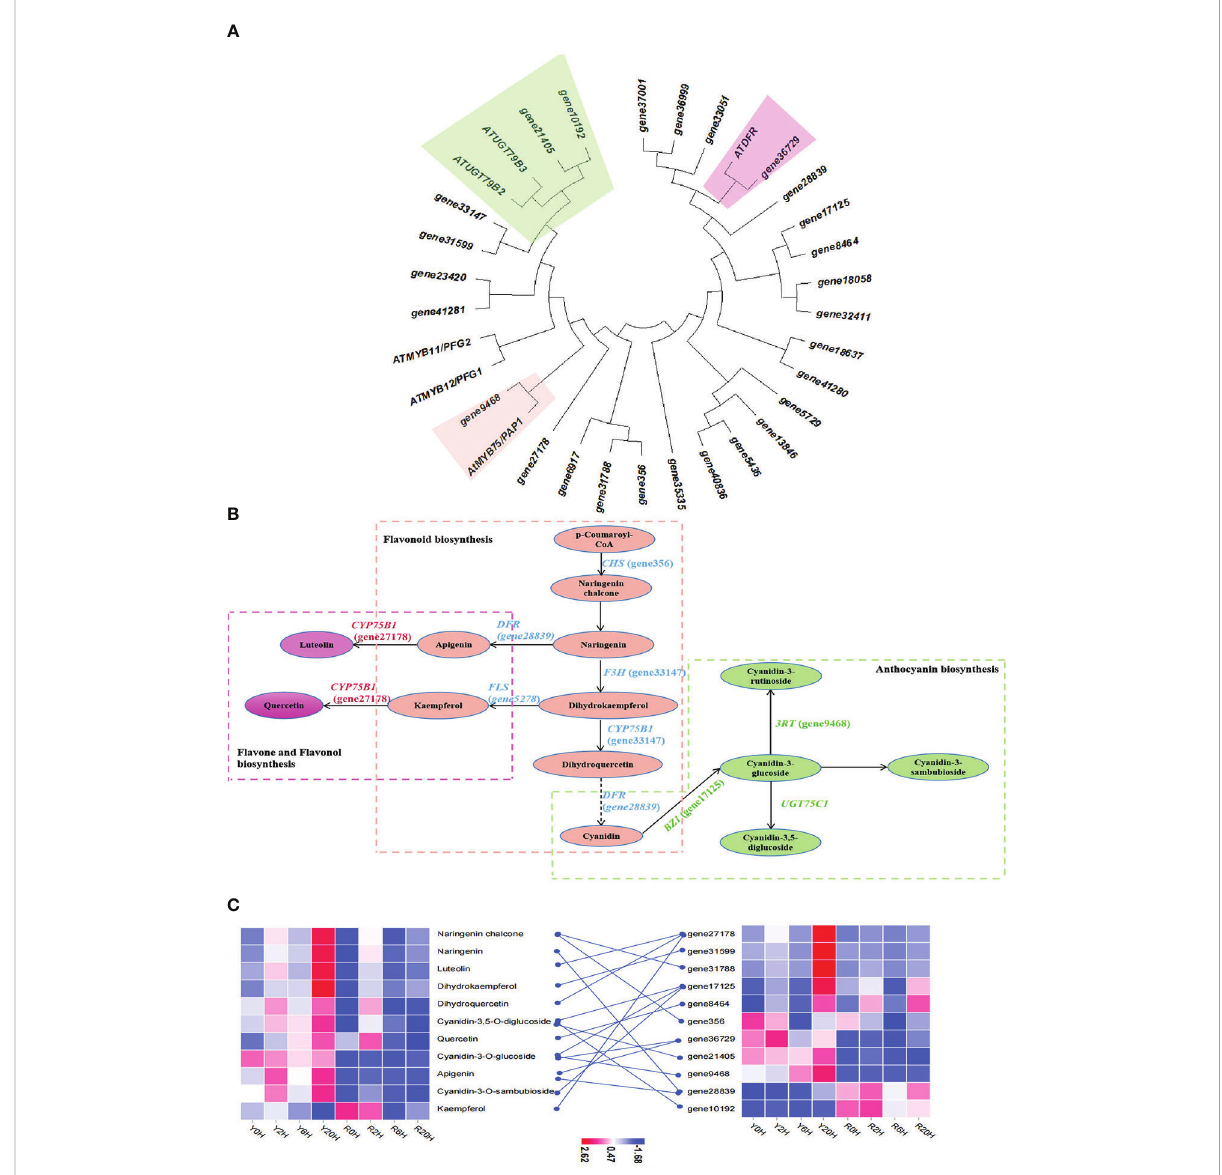
FIGURE 4 Metabolites and genes involved in fl avonoid biosynthesis and anthocyanin biosynthesis. (A) Maximum likelihood phylogenetic tree of the key genes of the fl avonoid and anthocyanin biosynthetic pathways. The colored blocks highlight the relationship between genes involved in fl avonoid, anthocyanin, and fl avone biosyntheses identi fi ed in this study and the genes of the same pathway in Arabidopsis thaliana . (B) Flavonoid biosynthetic mechanisms associated with cold resistance in the rubber tree. The green dashed box represents anthocyanin biosynthesis, the orange dashed box represents fl avonoid biosynthesis, and the pink dashed box represents fl avone and fl avonol biosynthesis. Ellipses in the same color represent the same pathway, and the names in parentheses beginning with the term “ gene ” are the IDs of the genes annotated in this study. (C) The heatmap of metabolites and genes involved in fl avonoid biosynthesis, anthocyanin biosynthesis, and fl avone biosynthesis based on the FPKM of key genes and the content of